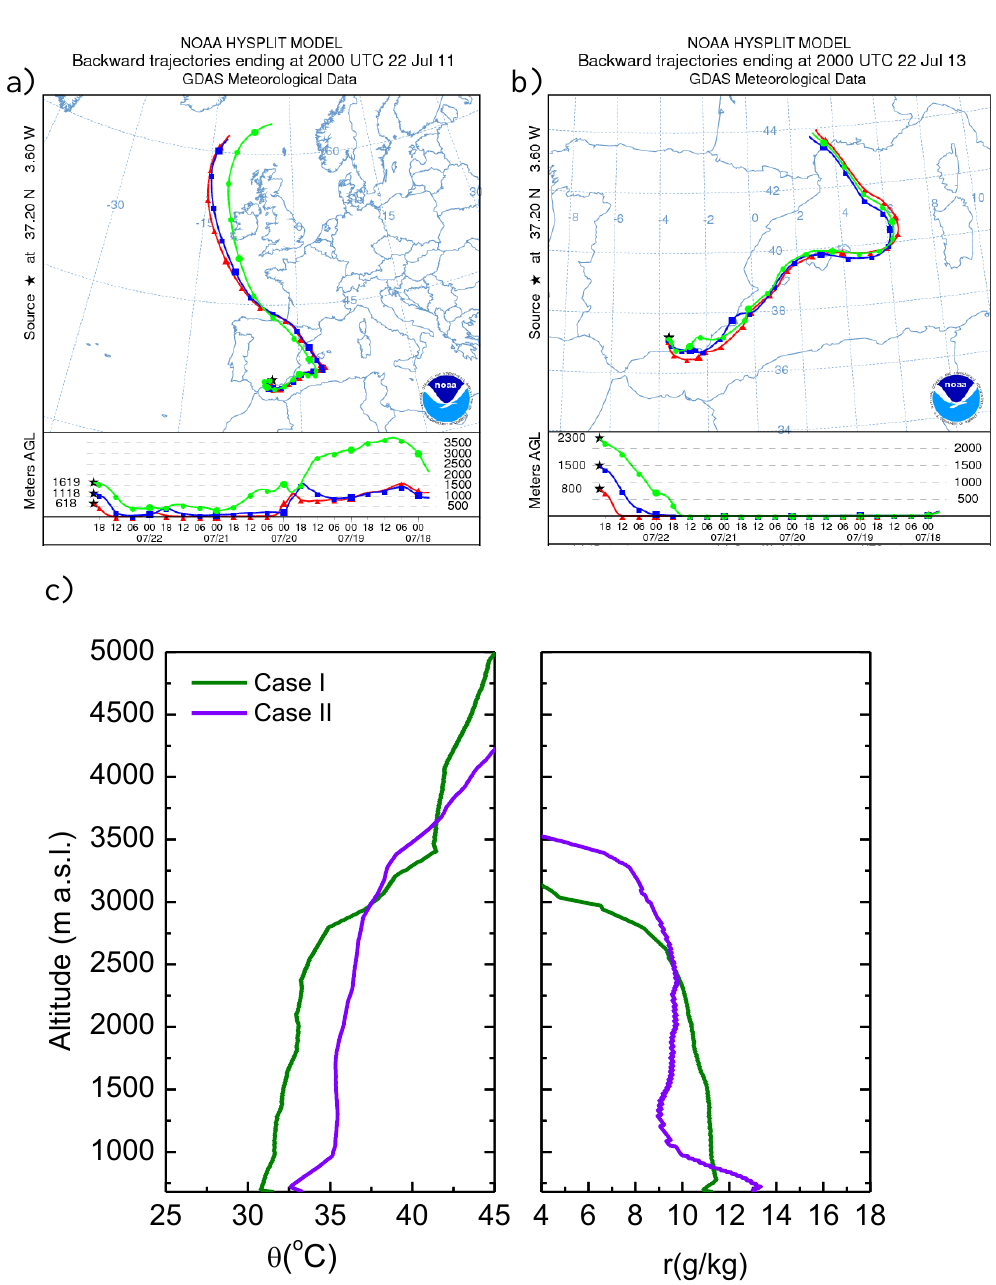
Figure 4. (a) 5-day back trajectories of the air masses ending on 22 July 2011 at 20:00 at Granada at three altitude heights within the 1330– 2330ma.s.l. height range. (b) 5-day back trajectories of the air masses ending on 22 July 2013 at 20:00 at Granada at three altitude heights within the 1300–2700ma.s.l. height range. (c) Vertical profiles of θ (in ◦ C) and r (in gkg − 1 ) from radiosounding data on 22 July 2011